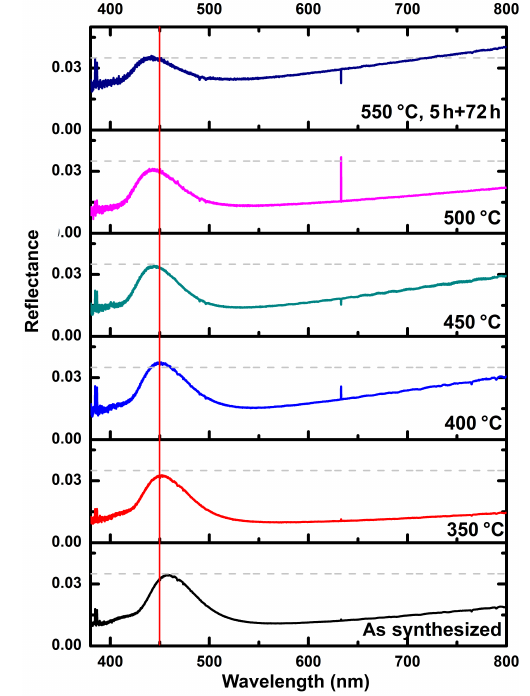
Figure 3. Reflectance spectra of the indium oxide inverse opals: average of the spectra before heat treatment, and spectra after heat treatments at different temperatures. The grey horizontal line marks the maximum reflectance value of 3.5% after 77h treatment at 550 ◦ C. The vertical red line at 450nm serves as a guide for the eye to recognize the shift of the maximum intensity.